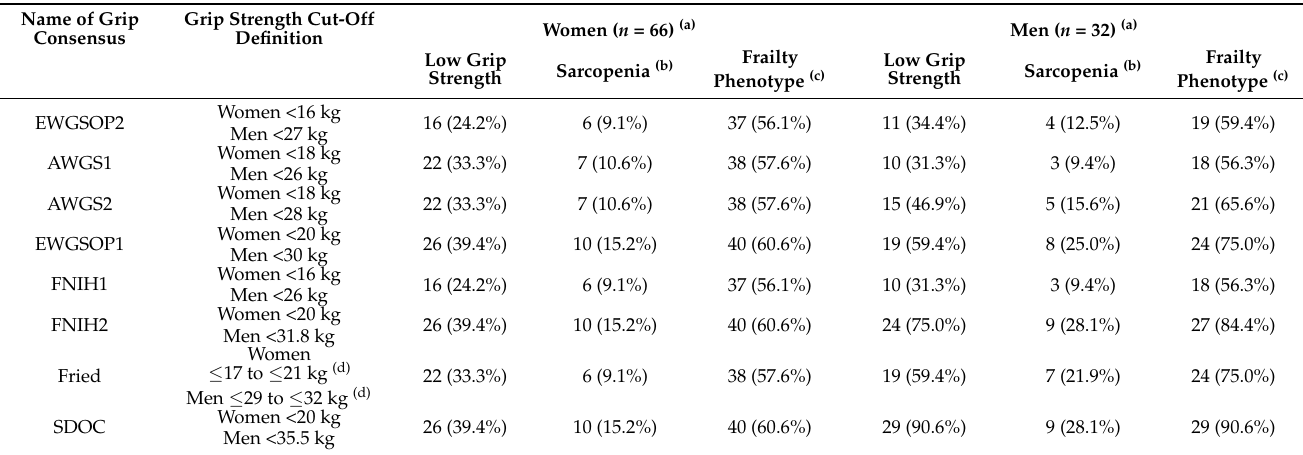
Table 4. Prevalence of low grip strength, sarcopenia, and frailty phenotype based on EWGSOP2 cut-off definition of low grip strength compared with other cut-off definitions of low grip strength, by gender ( n =